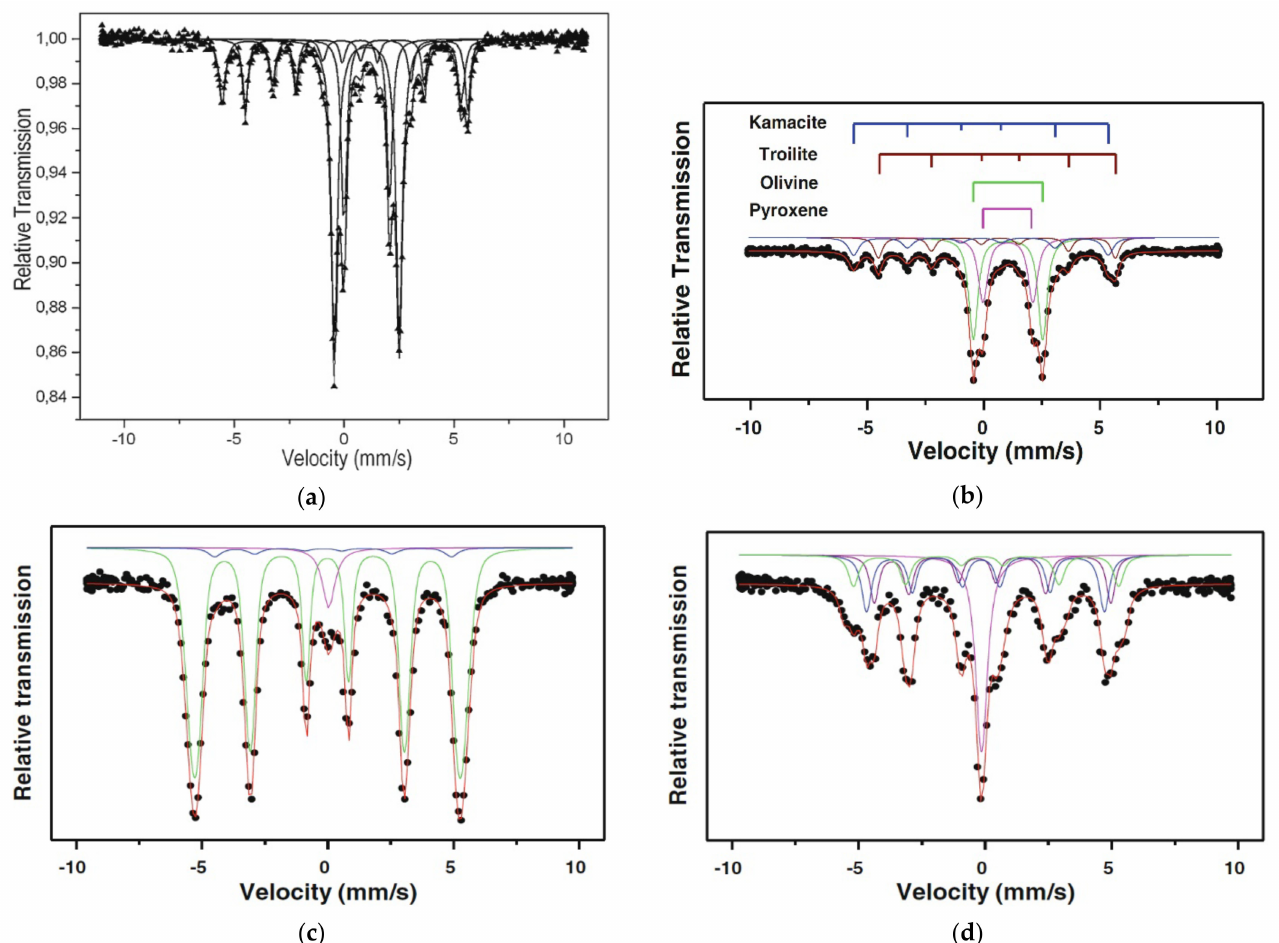
Figure 15. Room temperature Mössbauer spectra of equilibrated ordinary chondrite Carancas H4-5 measured in [63] ( a ) and in [64] ( b ) as well as extracted metal particles ( c ) and those after chemical treatment ( d ) from the latter Reference. Indicated components are the results of the fits. Adapted from References